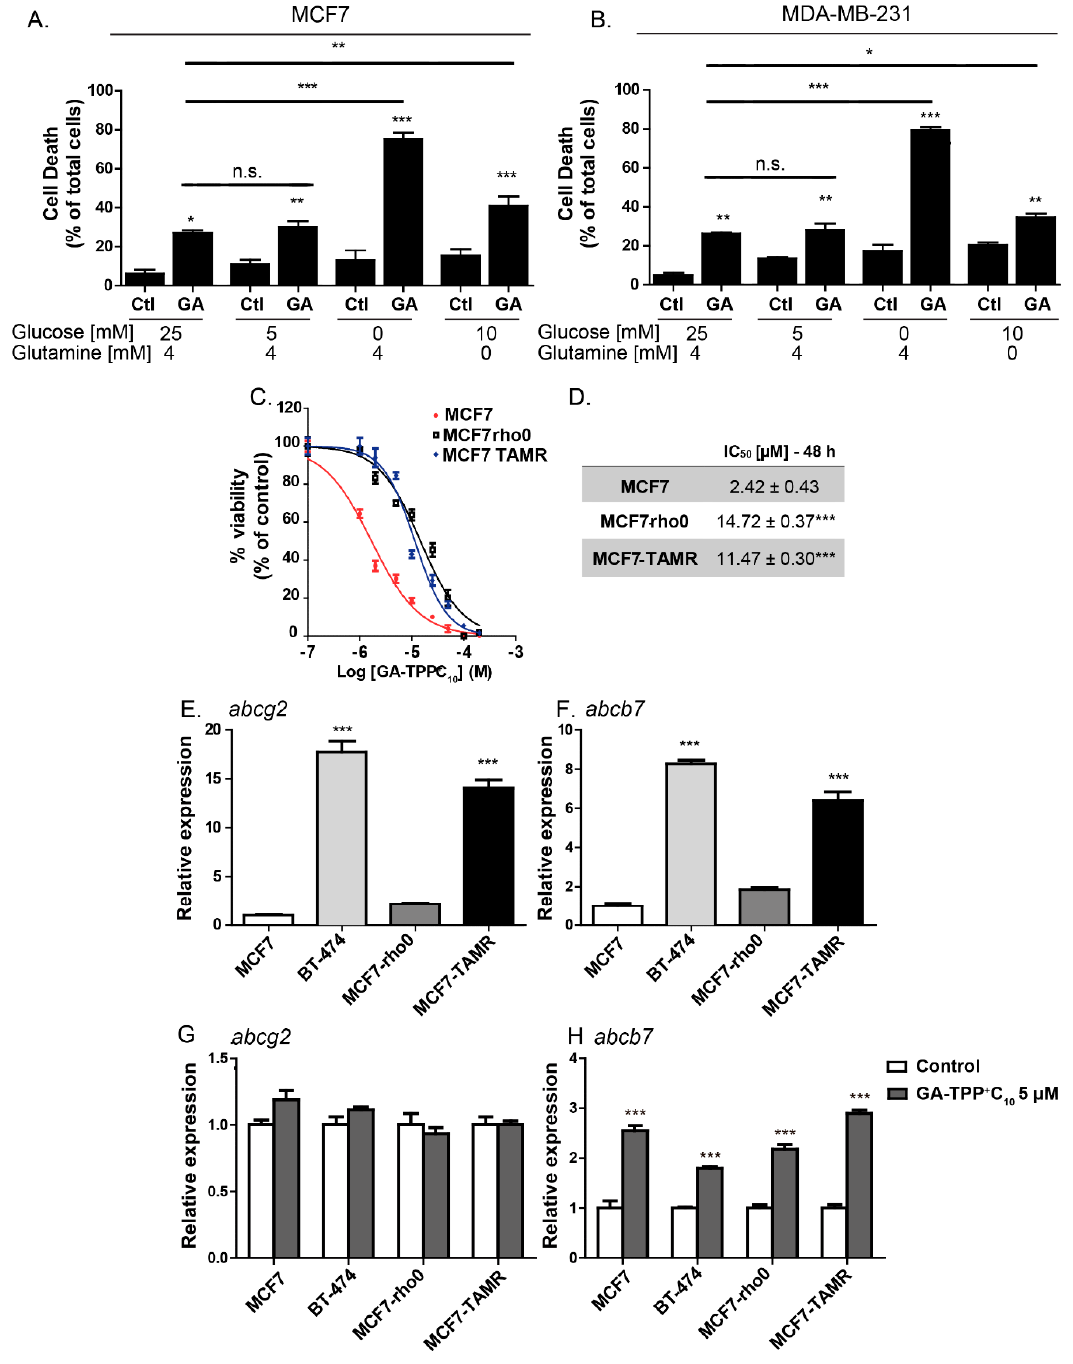
Figure 2. The anticancer effect of GA-TPP + C 10 relies on substrate availability and promotes increased expression of the mito-ATP-binding cassette (ABC) transporter. ( A ) Effect of 10 µM GA-TPP + C 10 on cell death induction in the MCF7 and ( B ) MDA-MB-231 cells cultured in different conditions of glucose and glutamine availability. The BC cells were grown in conditioned culture medium with different substrate availabilities 24 h before GA-TPP + C 10 treatment. ( C , D ) Decreased viability induced by GA-TPP + C 10 in wild-type MCF7 cells, cells devoid of mitochondrial DNA (MCF7-rho0) and cells with reduced mitochondrial bioenergetics (tamoxifen-resistant MCF7-TAMR). ( E – H ) Basal mRNA expression and changes induced by GA-TPP + C 10 after 24 h in ATP-dependent transporters in the MCF7, BT-474, MCF7-rho0, and MCF7-TAMR cells, as measured by qPCR. Values are expressed as the mean ± SEM of three independent experiments. * p < 0.05, ** p < 0.01, *** p < 0.001 vs. the control or